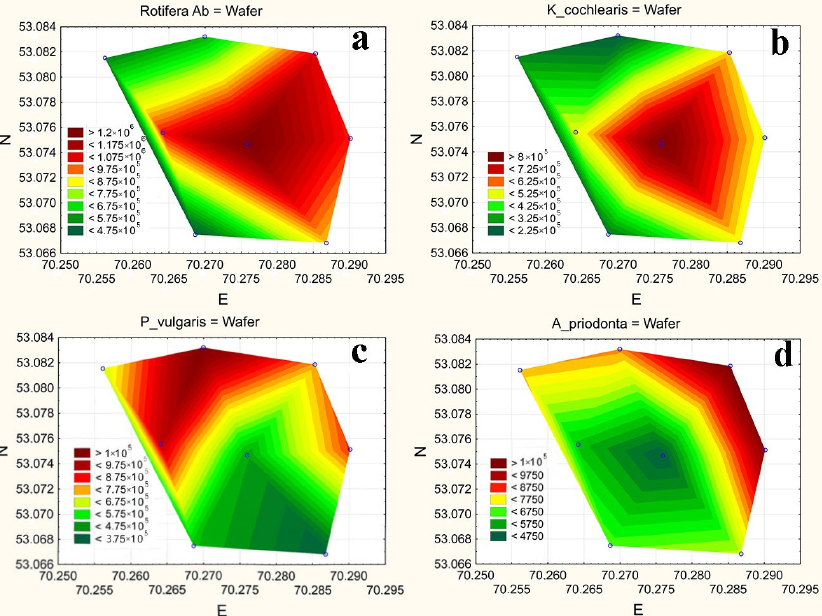
Figure 3. Spatial distribution of abundance of rotifers ( a ), K. cochlearis ( b ), P. vulgaris ( c ), A. priodonta ( d ) over the water area of the Borovoe Lake, 2019.